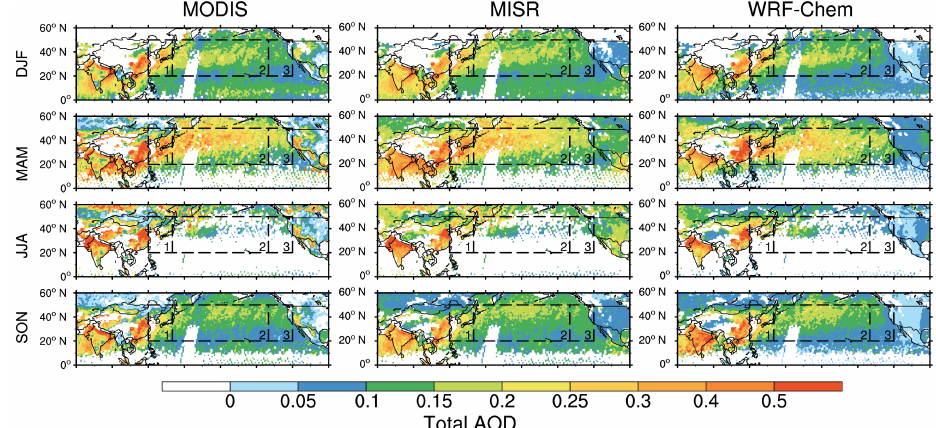
Figure 4. Spatial distributions of seasonal mean 550nm AOD from the retrievals of MODIS and MISR onboard Terra and the WRF-Chem simulation for the period 2010–2014. The daily results from MISR, MODIS, and WRF-Chem are only sampled for averaging when all of them have valid values at the same location and time. Three sub-regions are denoted by the black boxes: region 1 (20–50 ◦ N and 120–140 ◦ E), region 2 (20–50 ◦ N and 140 ◦ E–140 ◦ W), and region 3 (20–50 ◦ N and 140–120 ◦ W).